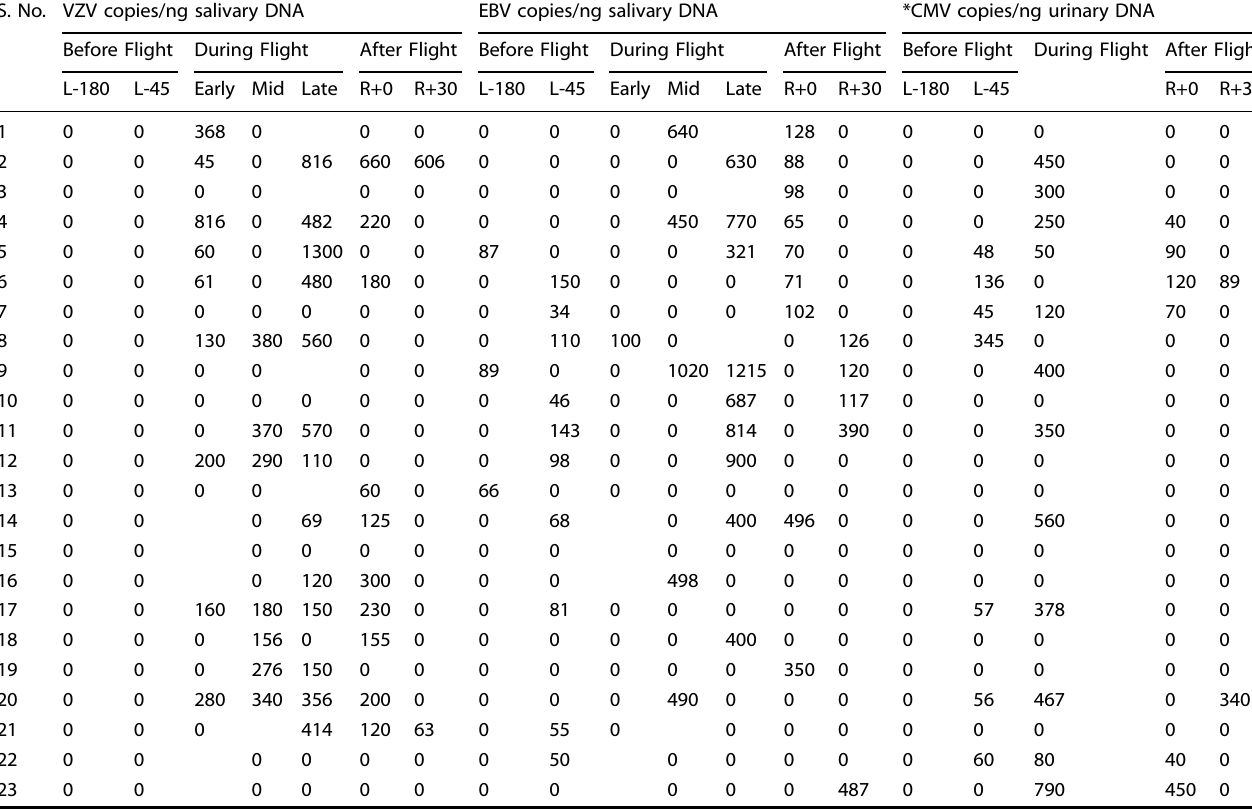
Table 1. Salivary VZV, Salivary EBV and urinary CMV copies in the 23 international space station crewmembers before, during and after the fl ight S. No. VZV copies/ng salivary DNA EBV copies/ng salivary DNA